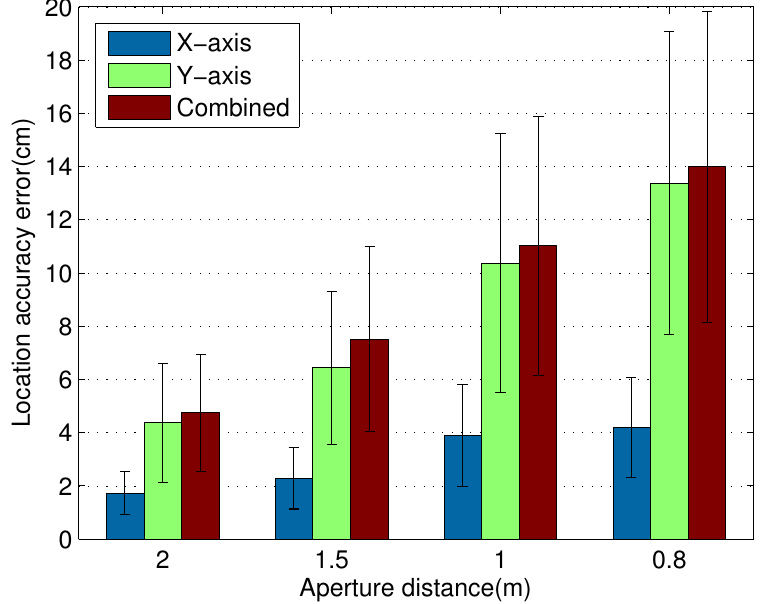
Figure 11. Localization accuracy error comparison with regard to the aperture distance. The bars represent the average localization accuracy errors in x-axis, y-axis and combined dimension, respectively. Additionally, the whiskers represent the standard deviations of the corresponding localization accuracy